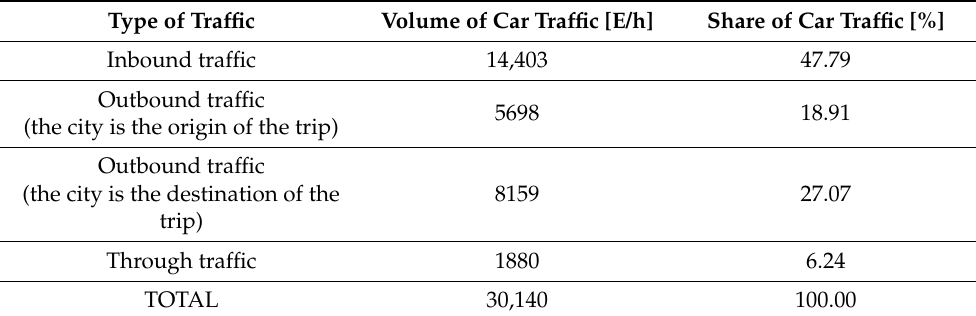
Table 3. The volume and share of car traffic during the morning rush hour in Bielsko-Biała city.